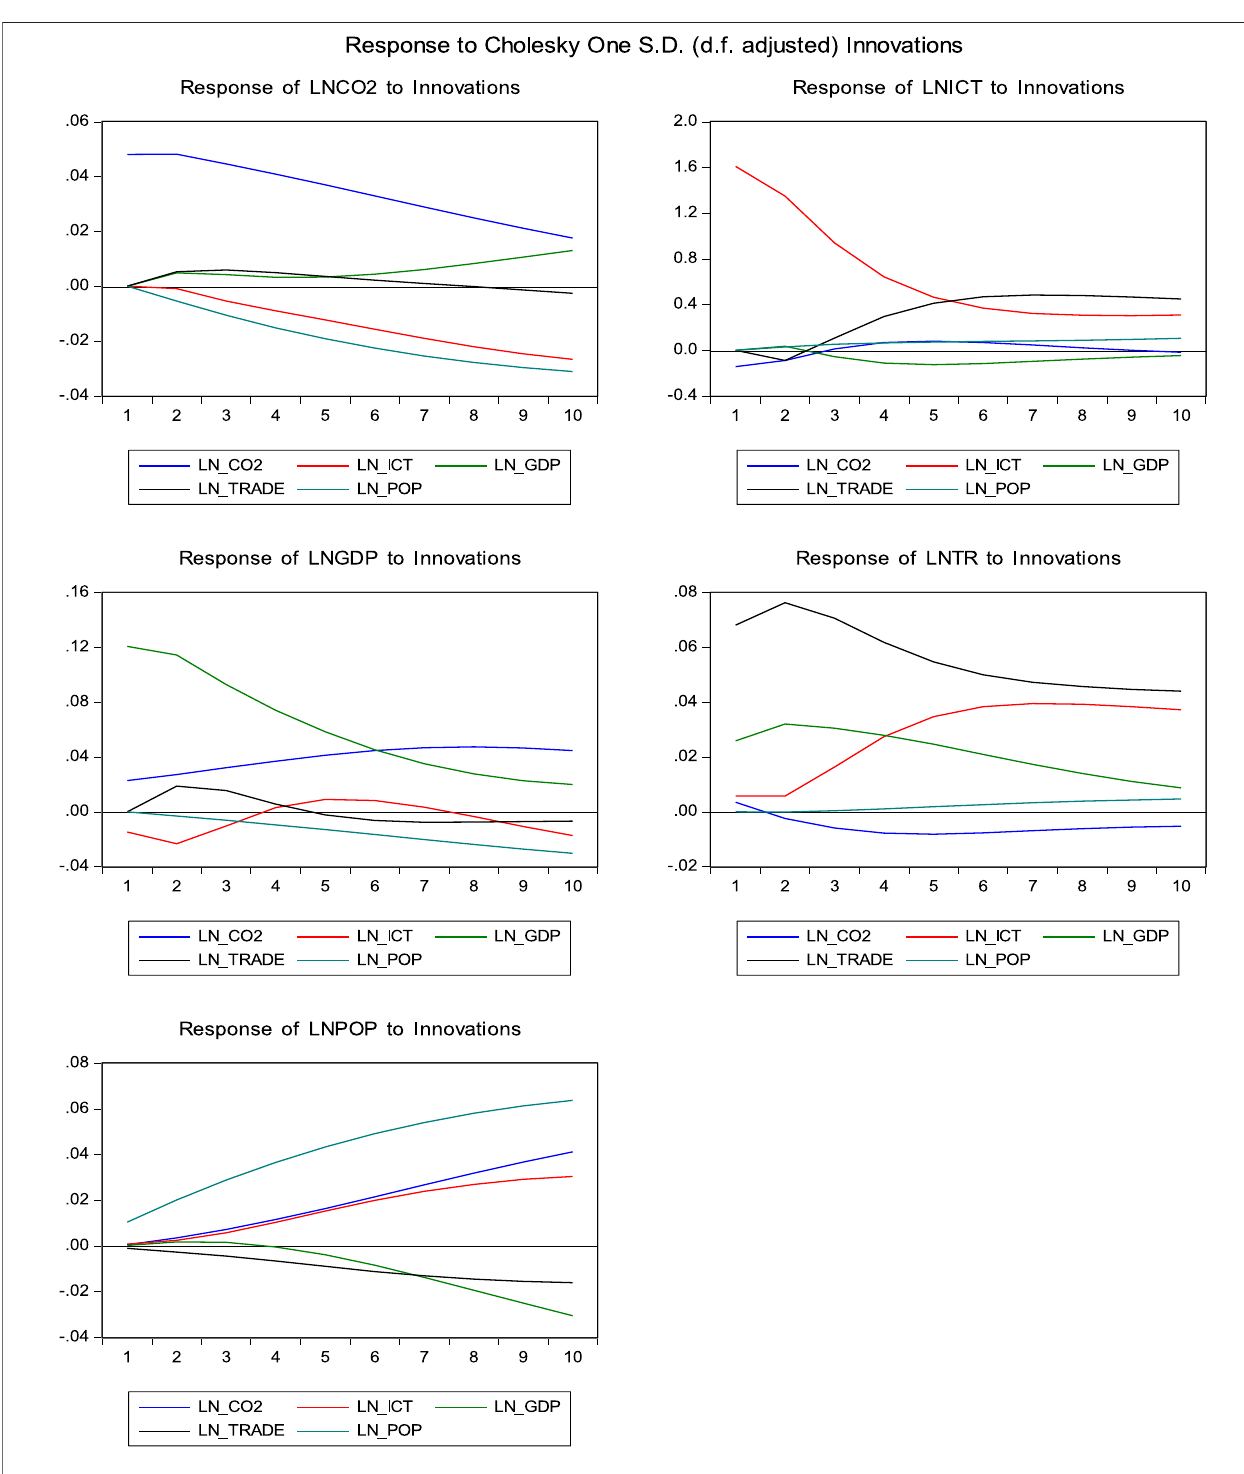
FIGURE 2 | Response to Cholesky One S.D